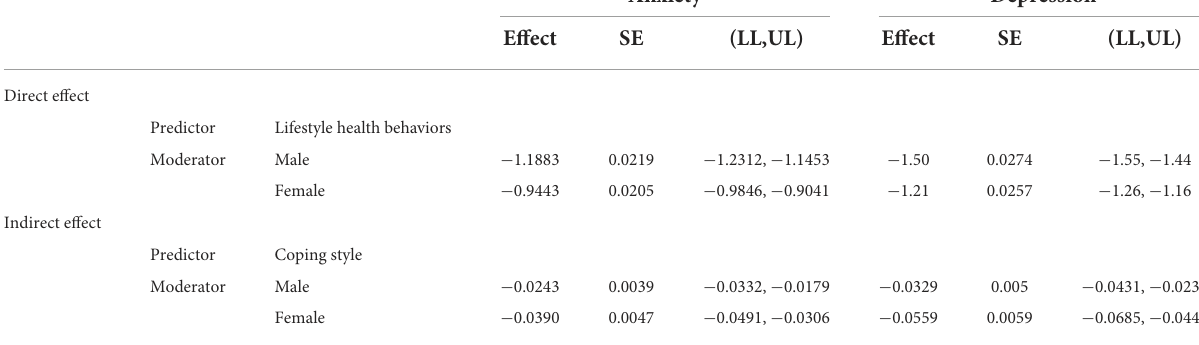
TABLE 7 Bootstrapped conditional direct and indirect